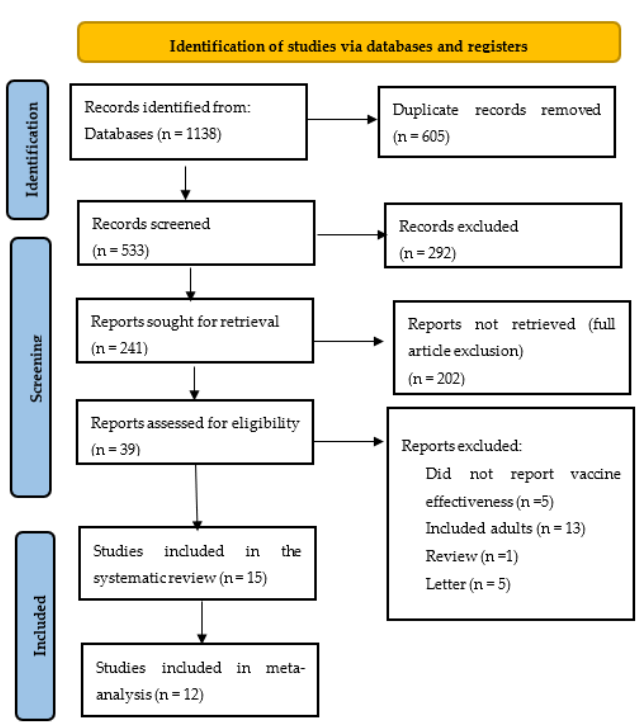
Figure 1. PRISMA flow chart of the systematic review selection process.